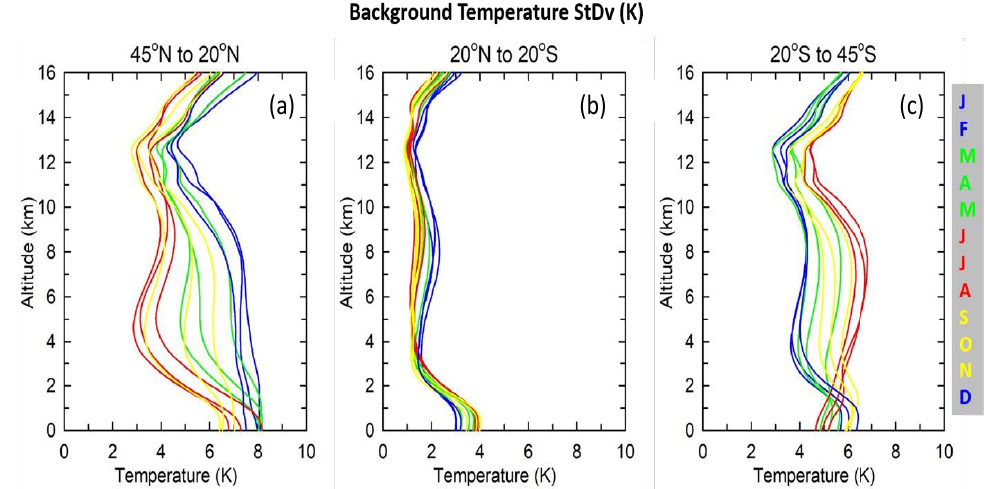
Figure 4. The same as Figure 3 but for background temperature standard deviation.